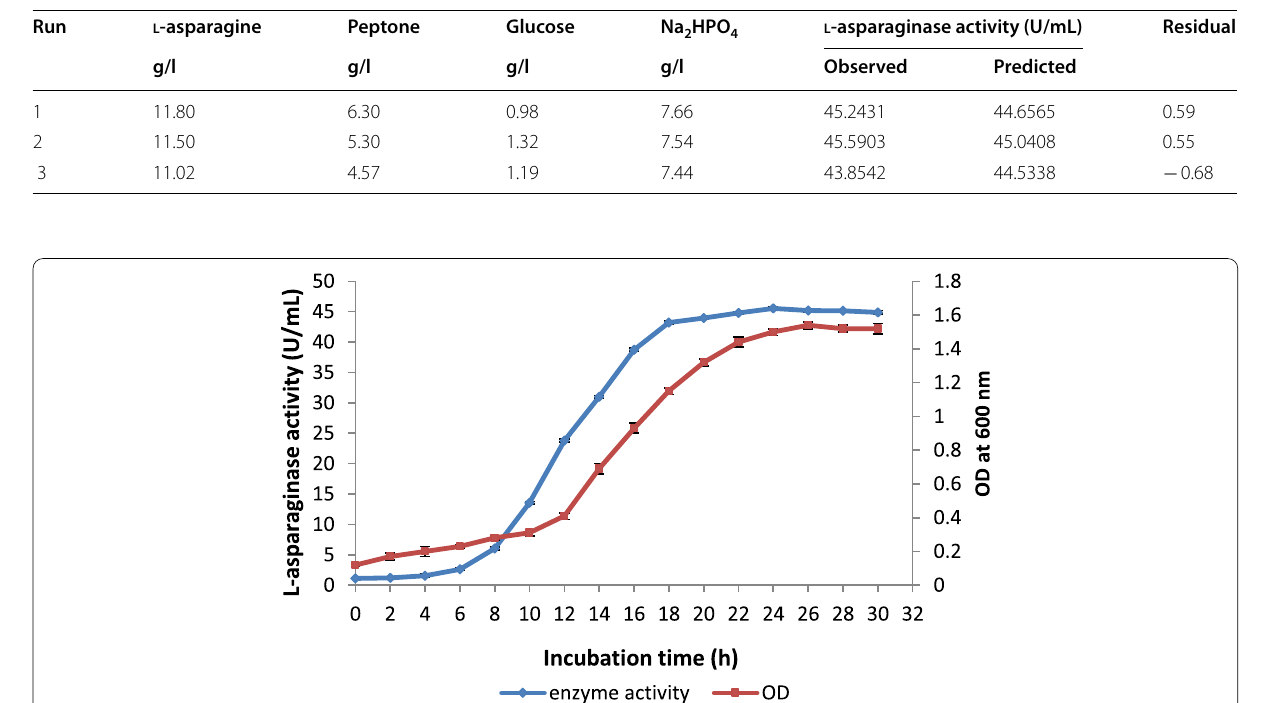
Fig. 4 l -asparaginase production profile and growth curve of Acinetobacter baumannii